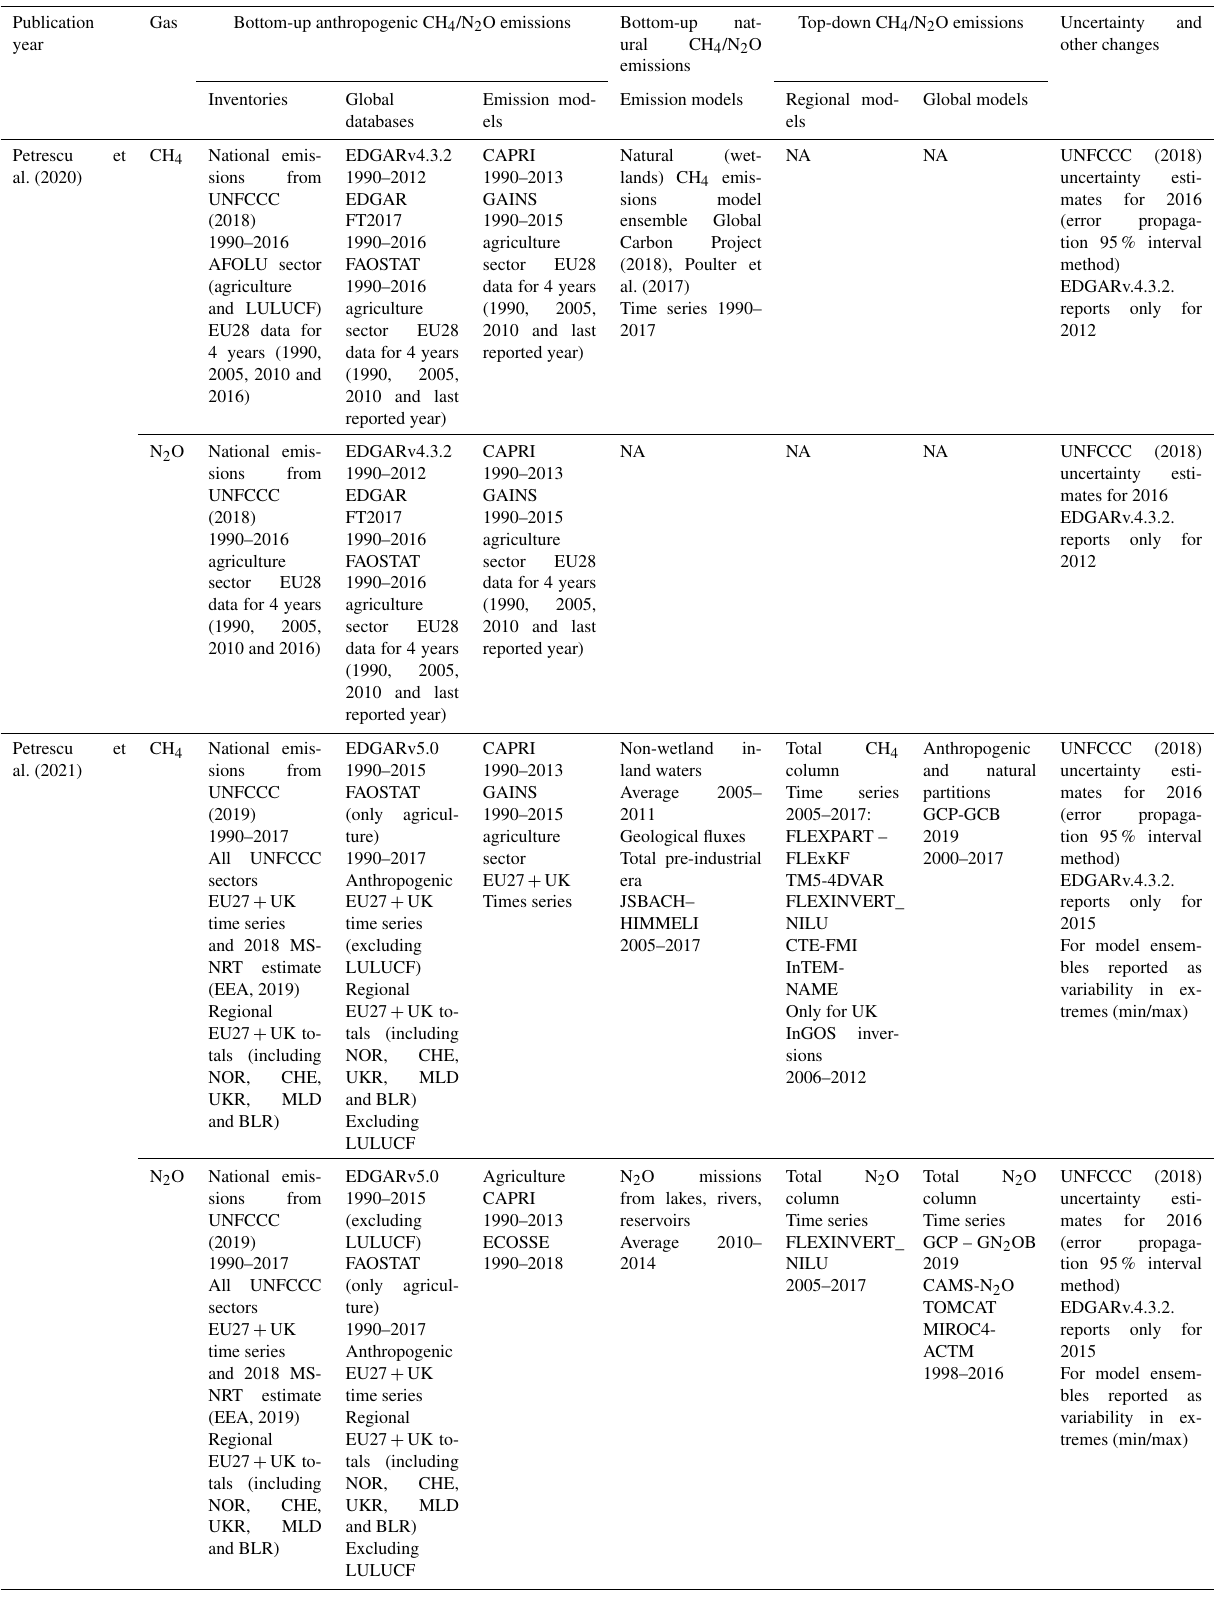
Table A2. Main methodological changes (in bold) of the current study with respect to Petrescu et al. (2020, 2021); NA cells mean that there are no data